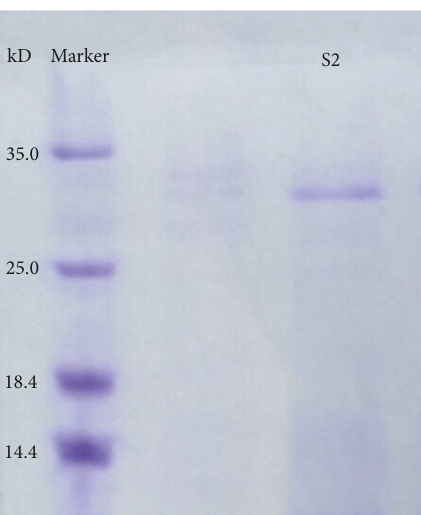
Figure 1: Gel electrophoresis bands of marker and purified col- lagenase (S2).